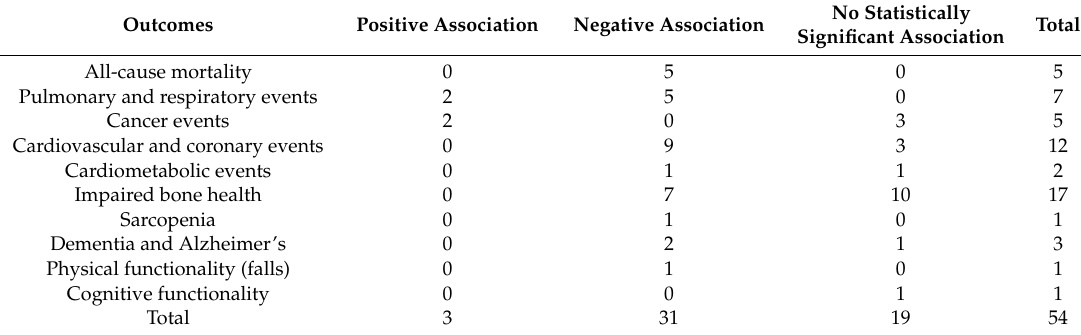
Table 3. Numbers and direction of associations between 25(OH)D and the outcomes selected for this SR. Positive associations (or direct associations) are those when risk of event measured at follow-up increased with the increase of 25(OH)D levels at baseline; Negative (or inverse associations) are those representing an increased risk of event incidence at follow-up with the decrease of 25(OH)D levels at baseline; the third column reports non-statistically significant associations between 25(OH)D levels at baseline and risk of an event at